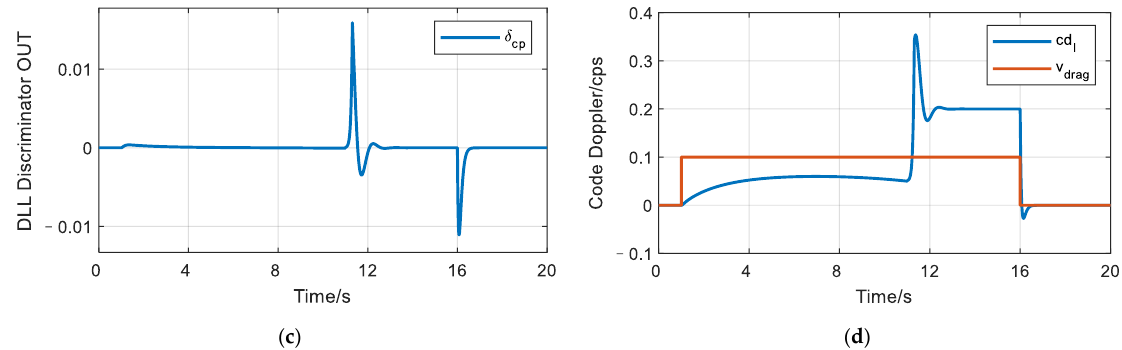
Figure 11. Theoretical simulation results of strategy 1. ( a ) Code phase differences; ( b ) Outputs of correlators; ( c ) Output of phase discriminator of the code loop; ( d ) Filter output of the code loop.